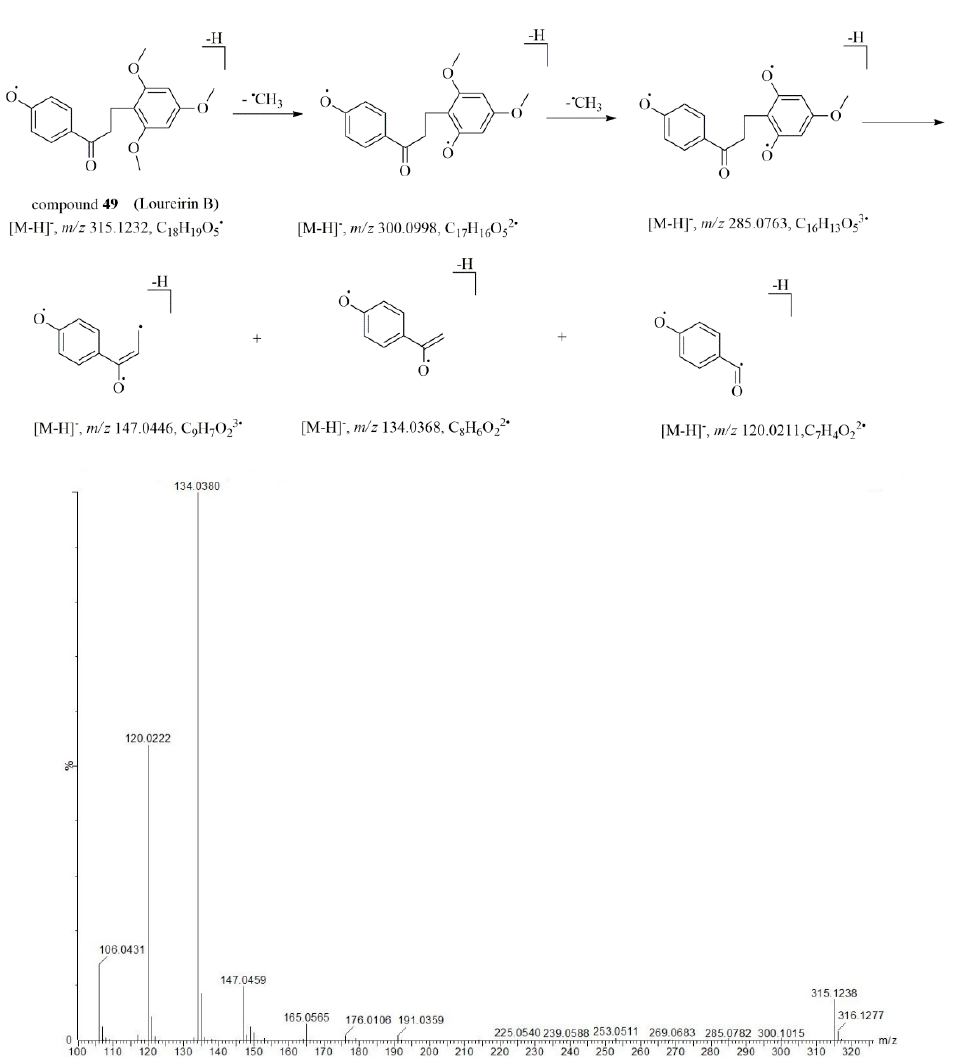
Figure 4. The hypothesized fragmentation pathway and MS/MS spectrum of compound 49 .